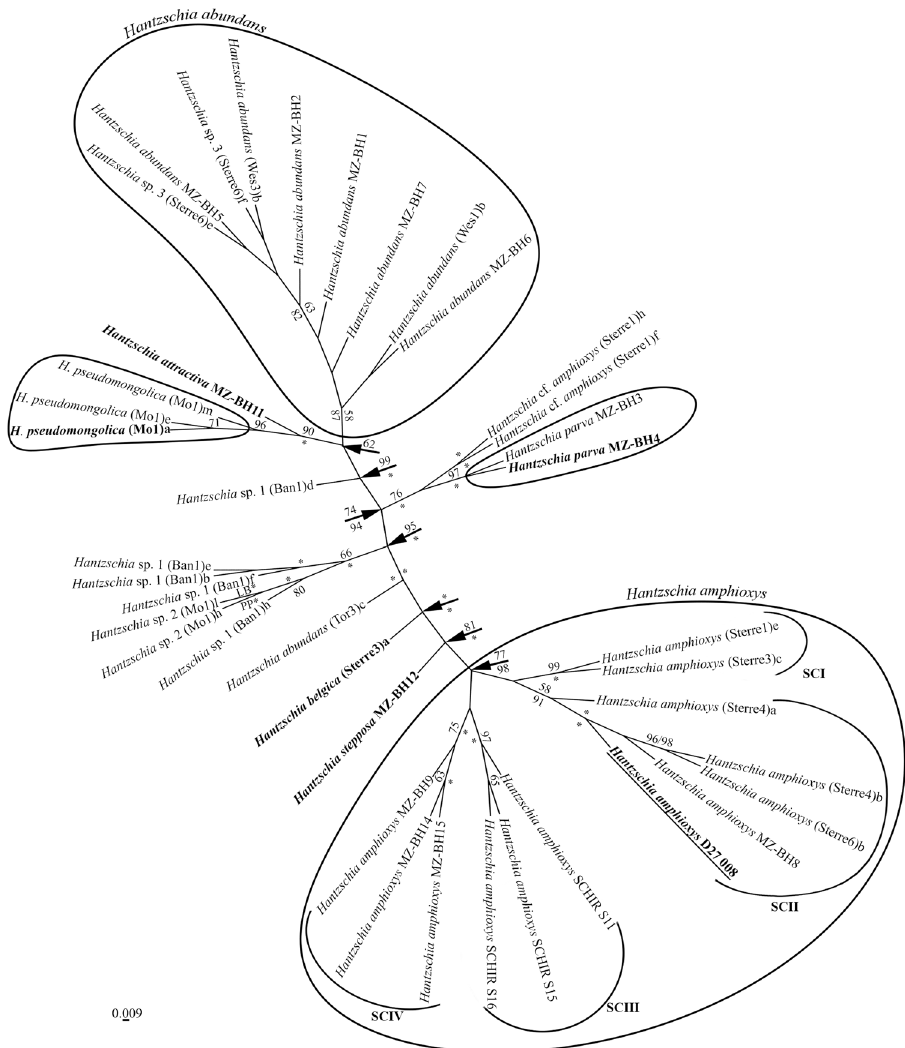
Figure 2. Bayesian tree for representatives of the different strains Hantzschia , from an alignment with 40 sequences and 1785 characters (partial rbc L gene and 28S rDNA fragments). Type strains indicated in bold. The epitype of Hantzschia amphioxys is underlined. Values above the horizontal lines (on the left of slash) are bootstrap support from RAxML analyses (< 50 are not shown); values below the horizontal lines (to the right of slash) are Bayesian posterior probabilities (< 80 are not shown). *100% statistical